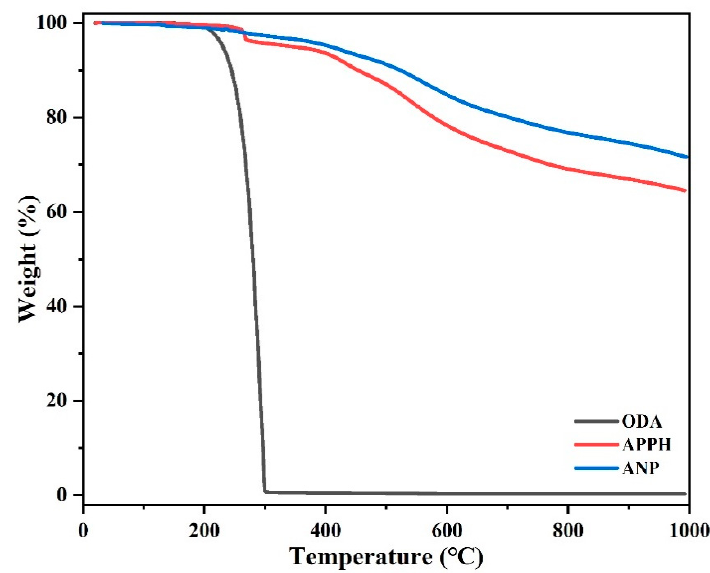
Figure 11. TGA of ODA, APPH, and ANP in a N 2